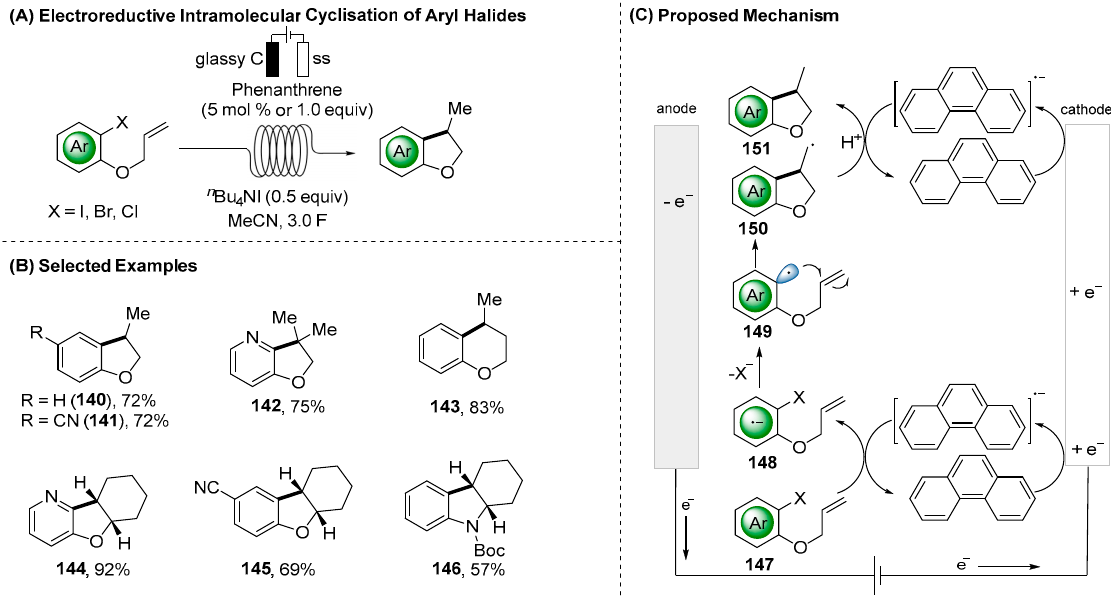
Figure 18. Phenanthrene mediated electroreductive intramolecular cyclisation of aryl halides by Brown group.